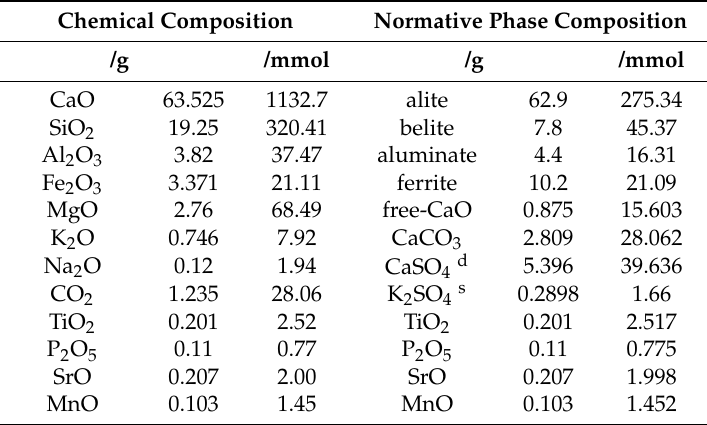
Table 1. Chemical composition of cement /100